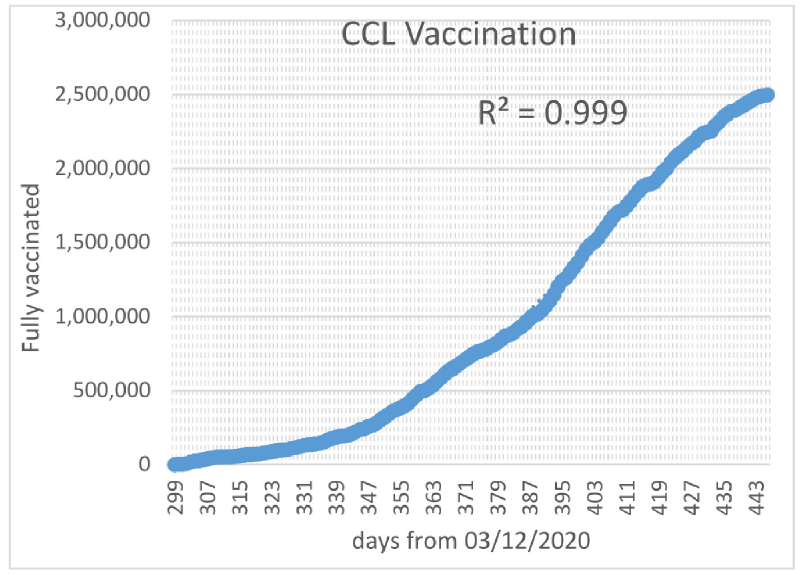
Fig 3. CCL vaccination rates, Jan. 3.–May 30,